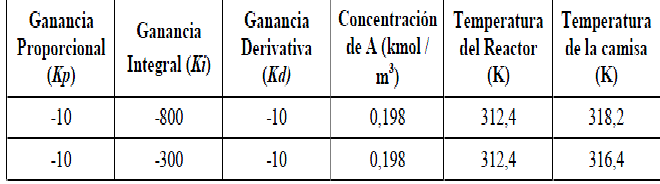
Tabla 4: Resultados de la simulación para el controlador PID del proceso reactor químico